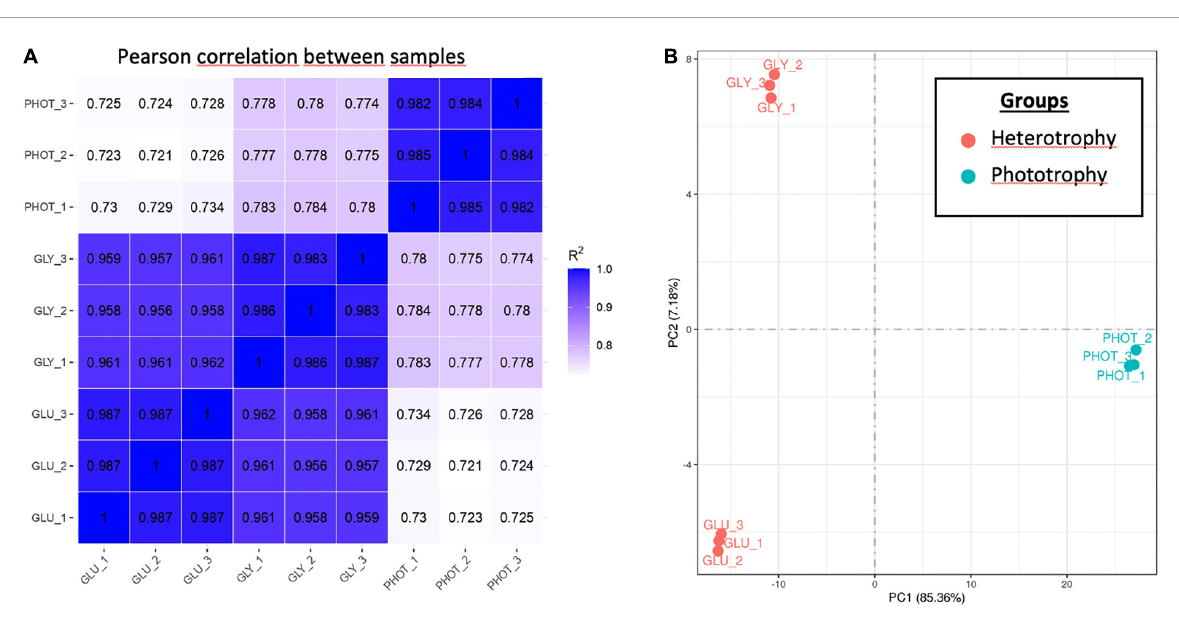
FIGURE4 Pearson correlation (PC) and principal component analysis (PCA) of the RNA-seq dataset for nine independent Galdieria sulphuraria samples harvested in exponential phase. (A) PC and (B) PCA made on the gene expression values (FPKM) of all samples. Samples are shown as independent biological replicates of three different culture conditions. PHOT_1, PHOT_2, and PHOT_3 are samples of G. sulphuraria grown in phototrophy without any carbon source. GLU_1, GLU_2, and GLU_3 are samples of G. sulphuraria grown in heterotrophy in the presence